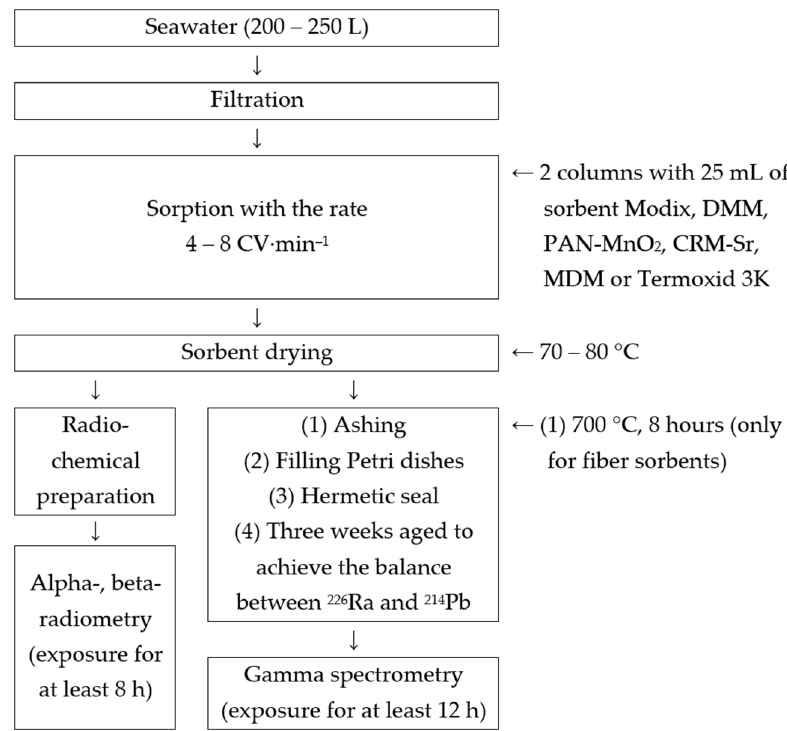
Figure 3. Scheme of sequence of steps taken in the method of 226 Ra and 228 Ra sorption.